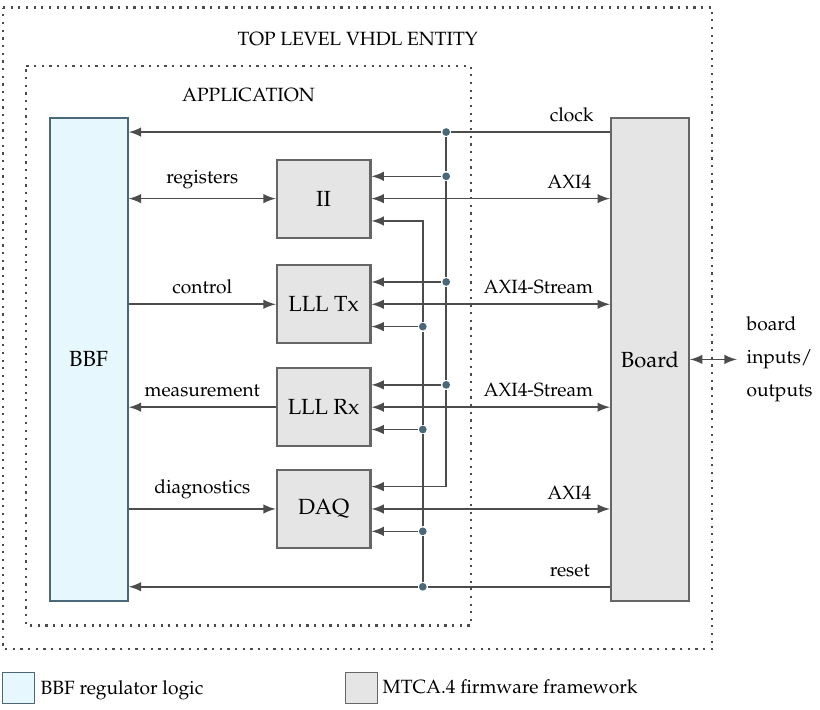
Figure 11. Structure of top level VHDL entity as defined by the MTCA.4 firmware